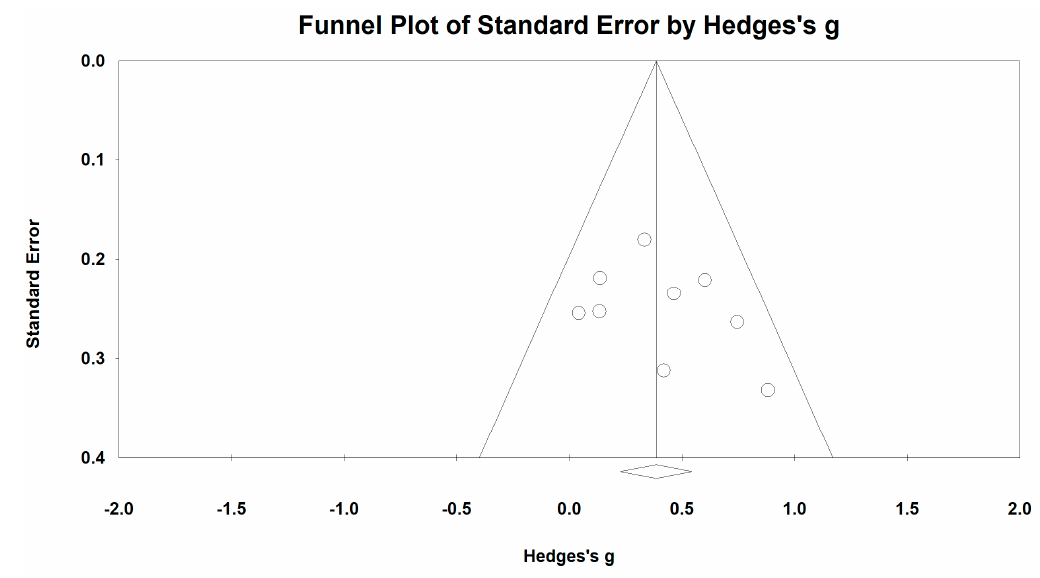
Figure 8. Funnel plot of publication bias for FVC.